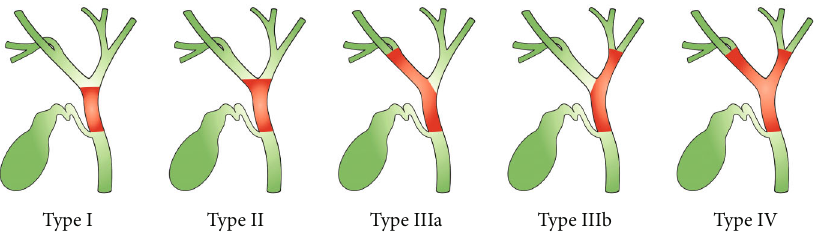
Figure 2: Classi fi cation of perihilar carcinoma according to Bismuth and Corlette.